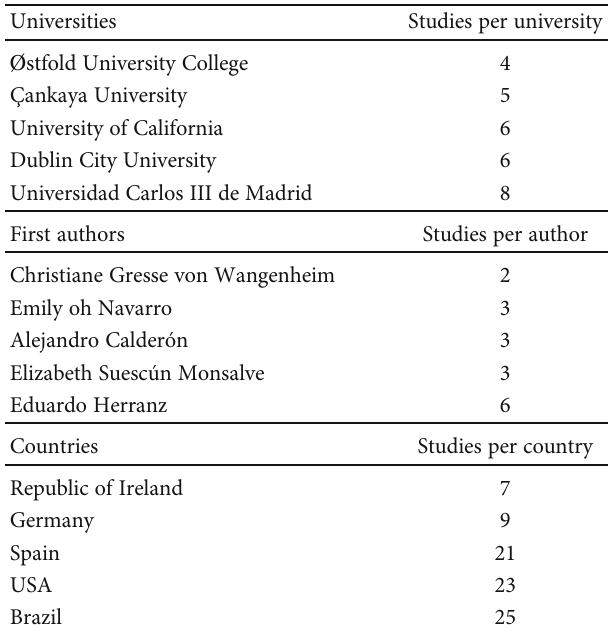
Table 9: Authors, universities, and countries that have had most published primary